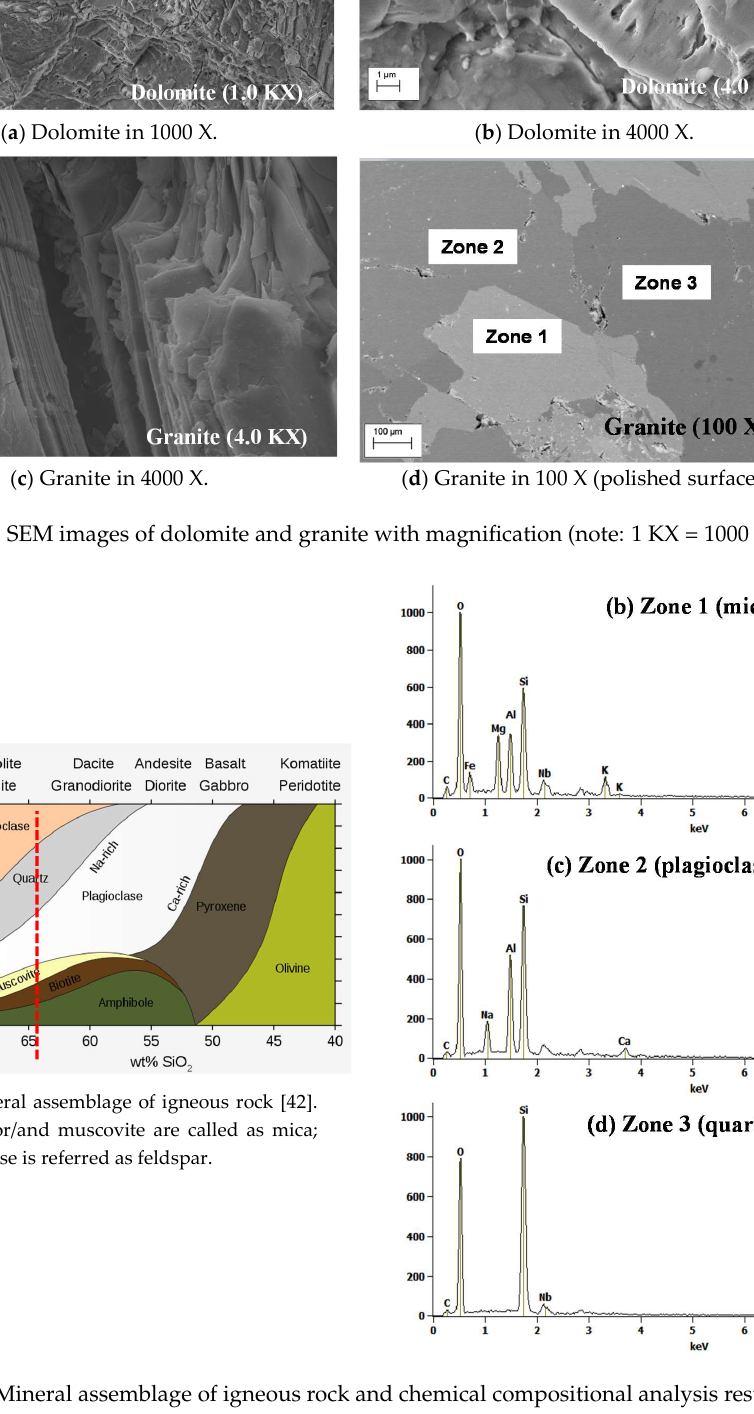
Figure 8. SEM images of dolomite and granite with magnification (note: 1 KX = 1000 X).